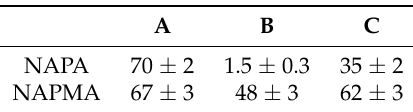
Table 1. Excited state lifetimes (in ns) of selected isotopomers of NAPA and NAPMA measured at the origin of the ππ ∗ transition by pump-probe experiments